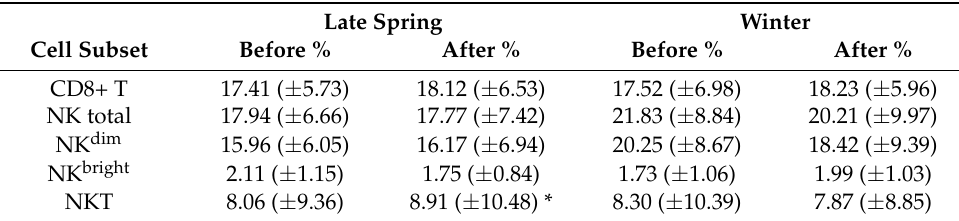
Figure 3. Systolic blood pressure prior to and following the late spring (May) and winter (January) forest walks. The middle line within the box represents the median, the middle dot within the box represents the mean, the boxes indicate the interquartile ranges between the 25th and 75th percentiles, and the whiskers show the most extreme observations in the box plot. Individual dots left from the boxes represent individual data values. Differences were considered statistically significant for p -values < 0.05. Statistically significant p -values are indicated on the horizontal lines outside the boxes. Table 3. Proportions of the examined cell subsets (100% = all peripheral blood mononuclear cells; data are presented as mean ± standard deviation); * p = 0.045 compared to the before